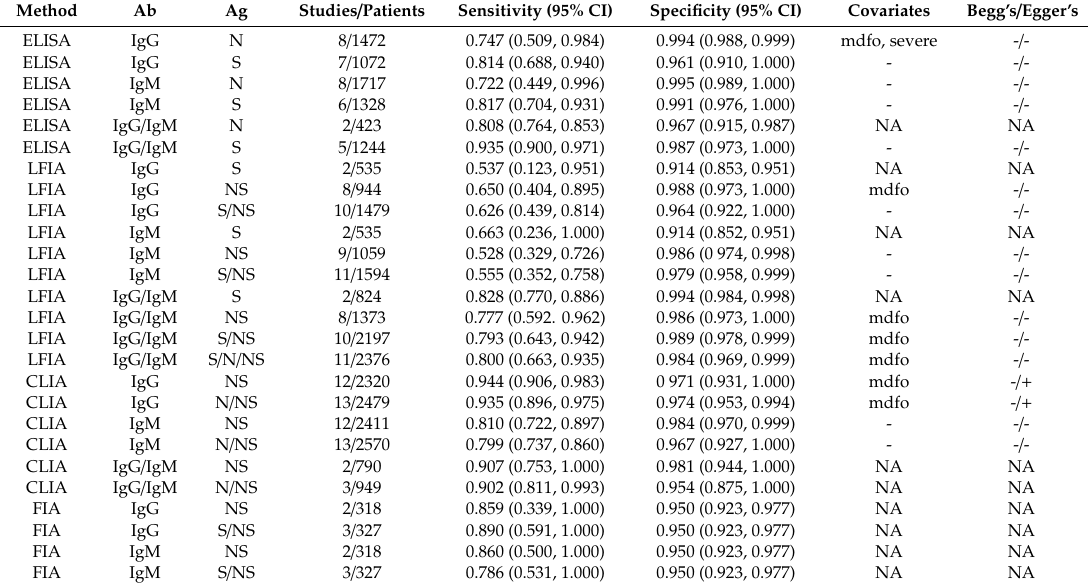
Table 2. Results of the meta-analysis for the di ff erent types of antibody tests. We list the characteristics of the included studies, the pooled sensitivity and specificity along with the 95% confidence intervals, the variables that were found statistically significant in meta-regression, and the results of the tests for publication bias. For the description of the test, the antibodies (Ab) and antigens (Ag), see Methods section (mdfo: mean days from onset; severe: percent of patients with severe or critical condition; NA: not applicable). N: nucleocapsid protein, S: spike protein, NS: nucleocapsid and Spike